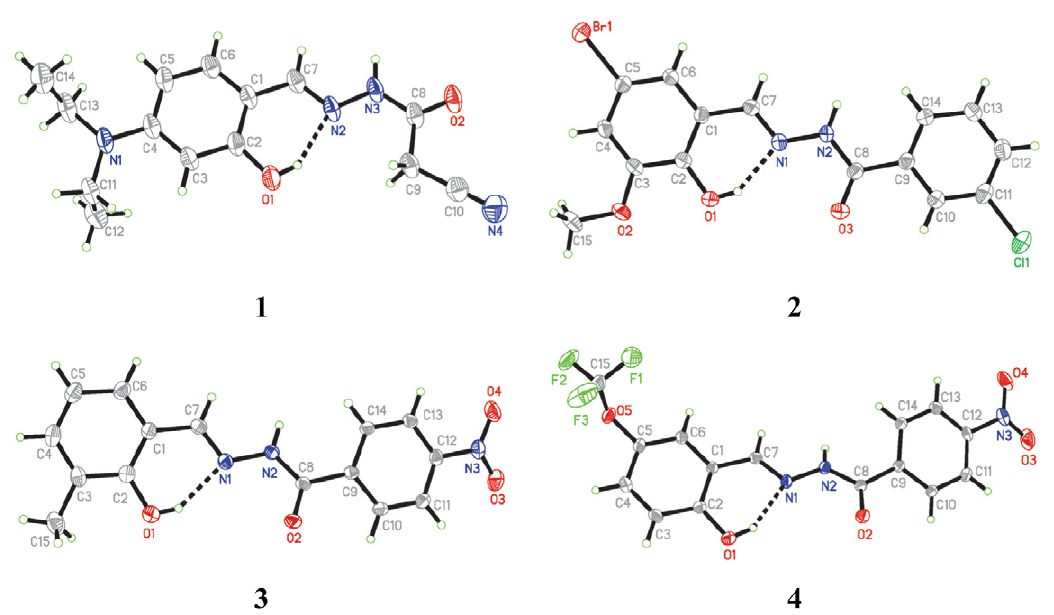
Figure 1. A perspective view of the molecular structures of the compounds 1 – 4 with the atom labeling scheme. Thermal ellipsoids are drawn at the 30% probability level. Hydrogen bonds are shown as dashed